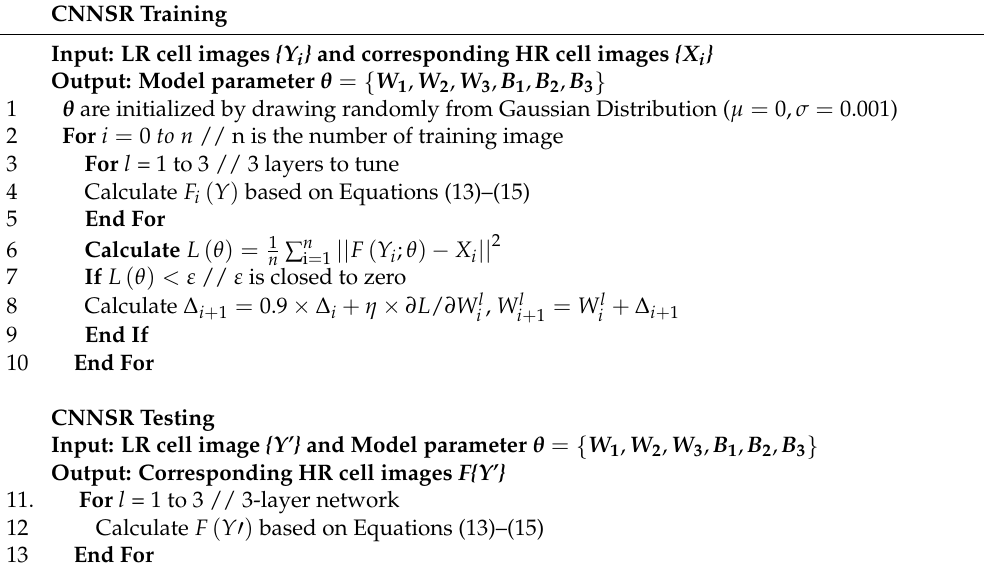
Figure 5. Convolutional neural network based super-resolution (CNNSR) processing flow including one off-line training and one on-line testing step. Table 3. Pseudo code for convolutional neural network based super-resolution (CNNSR). CNNSR